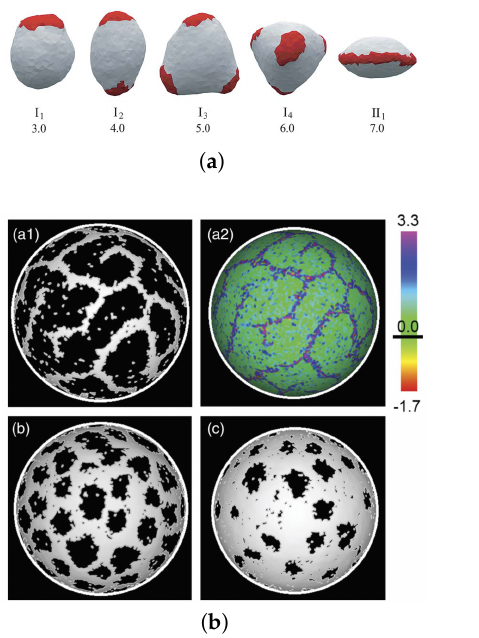
FIGURE 1 Thecompositionalpathforinvestigationofmodulatedphases is shown within the Ld Lo volume of DSPC/DOPC/POPC/CHOL. þ Schematic shows the progression along a r trajectory through the tetrahe- dral phase diagram as POPC is replaced by DOPC.